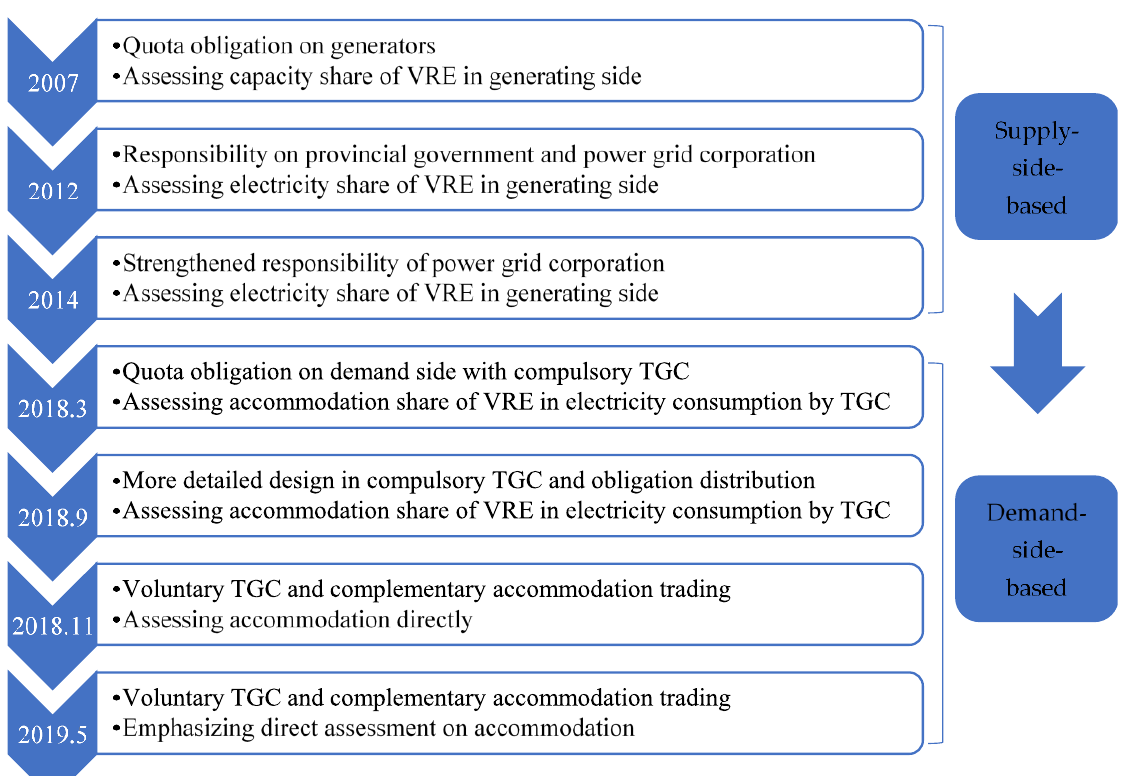
Figure 2. Evolution of renewable portfolio standard (RPS) policy: Characteristics on quota obligation and assessment, 2007–2019.